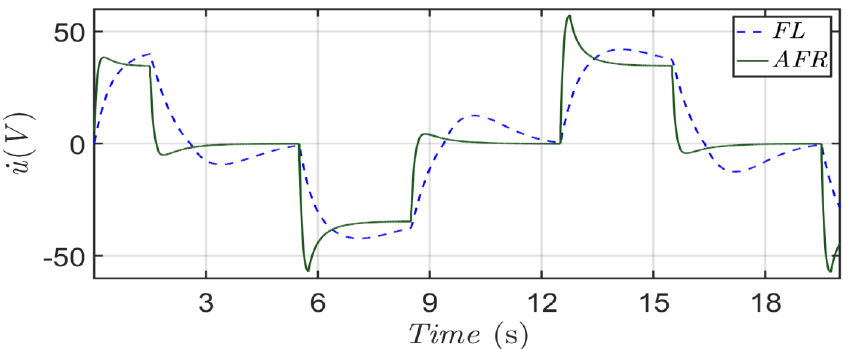
Figure 6. Histories of the overall control commands of the proposed method and feedback lineari- zation method.